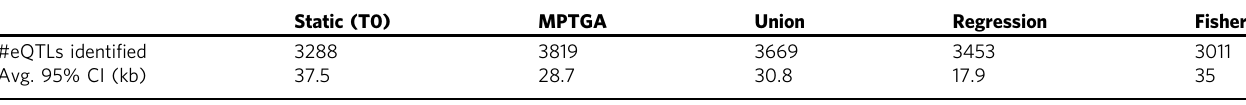
Table 1 Number of eQTL identi fi ed and average 1-LOD drop CI by different approaches (static, MPTGA, union, regression, and Fisher ’ s